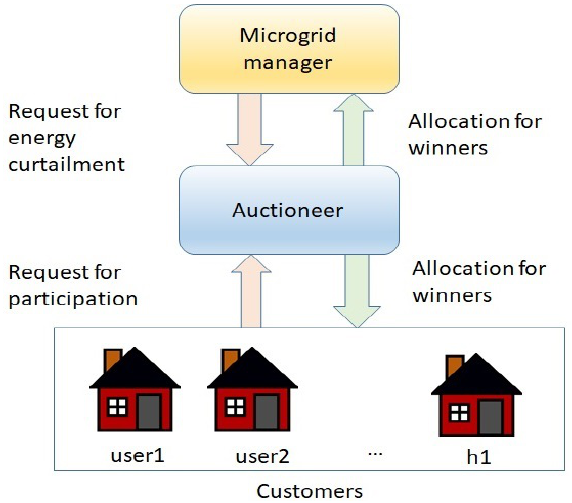
Figure 1. The system model for proposed